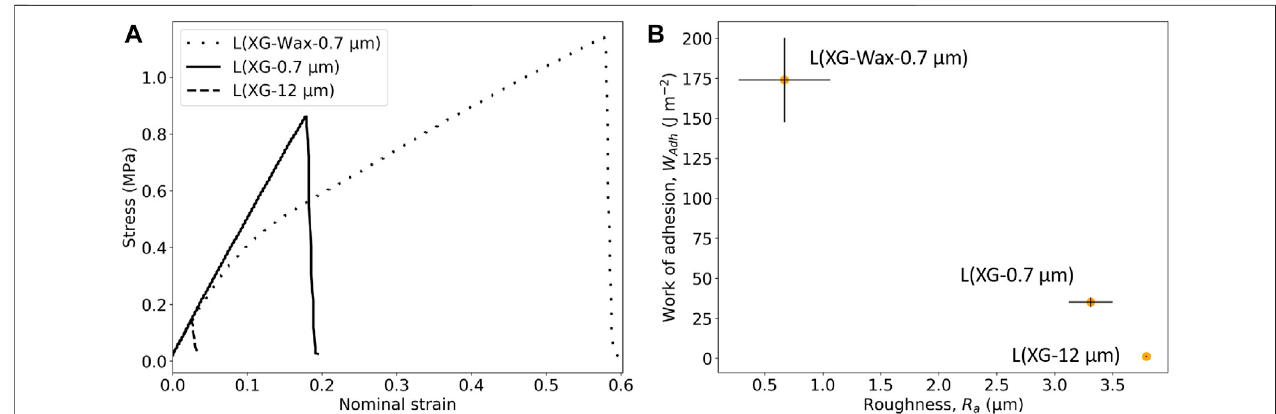
FIGURE11|(A) Probe-tackcurvesofCaCO 3 -containingsamplesat90%RH, (B) correlationbetweenthe W Adh at90%RHand R a forCaCO 3 -containingsamples. Vertical error bars indicate the standard error in the mean W Adh value, horizontal error bars indicate maximum and minimum R a values.